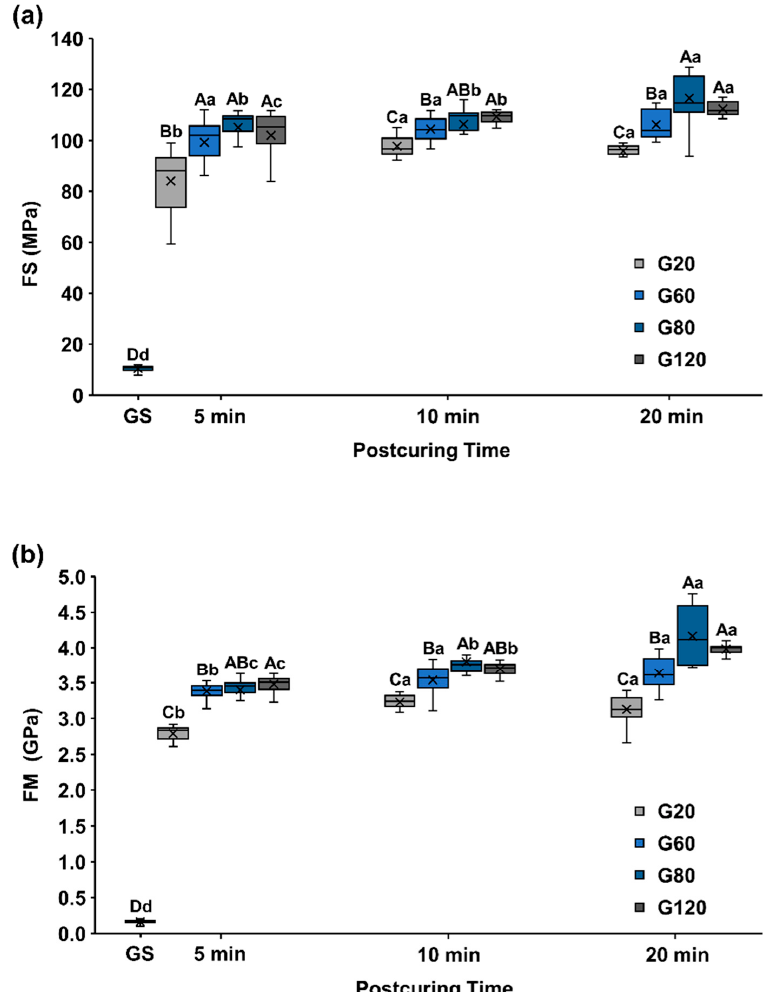
Figure 2. ( a ) Flexural strength (FS). ( b ) Flexural modulus (FM). Uppercase letters indicate significant differences by intensity within the same post ‐ curing time condition using Mann–Whitney with Bon ‐ ferroni’s correction ( p < 0.005, A > B > C > D), and lowercase letters indicate statistical differences by post ‐ curing time within the same intensity conditions using Friedman test with Bonferroni’s correc ‐ tion ( p < 0.0083, a > b > c > d). X mark means the average value of the data. FS and FM were significant differences according to the intensity and same post ‐ cur ‐ ing time, including GS ( p < 0.001). The green state (GS: 10.49 ± 0.97 MPa) differed signifi ‐ cantly low with the post ‐ curing intensity and time ( p < 0.001). The specimens post ‐ cured for 5 min had the highest FS in groups G60 (99.24 ± 8.97 MPa), G80 (105.05 ± 7.65 MPa),